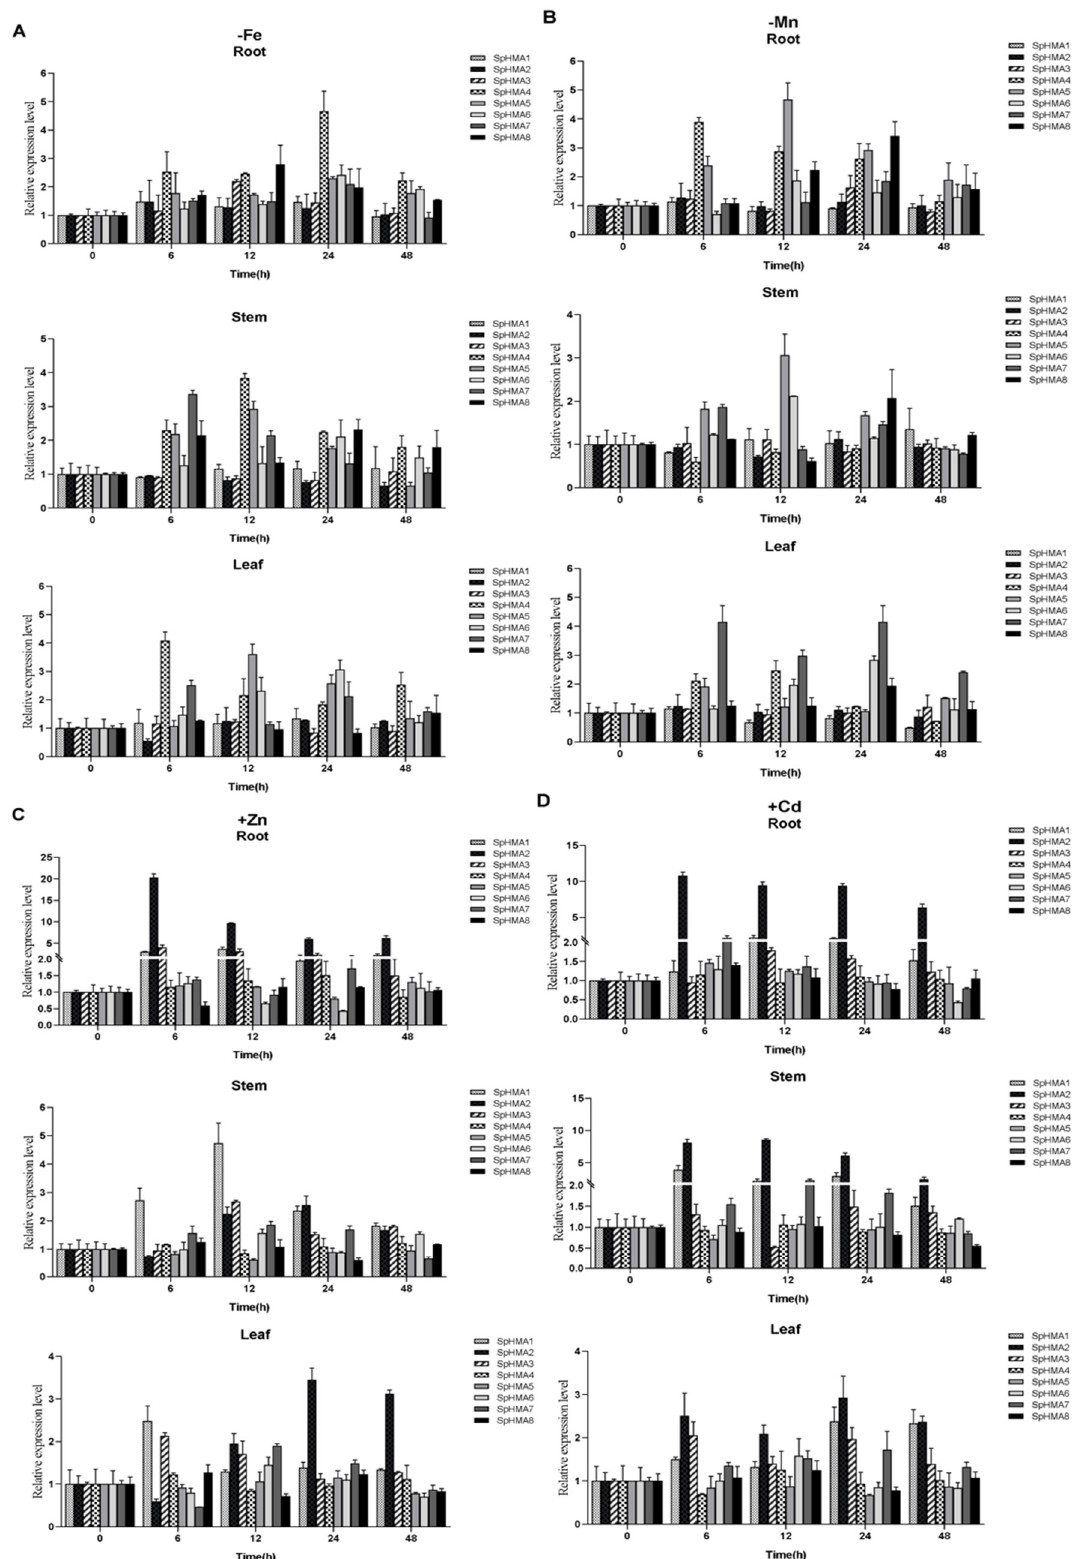
Figure 7. The qRT-PCR expression analysis of 8 SpHMAs under normal and stress condition. The stress treatment conditions were Fe ( A ), Mn ( B ) deficiency and Zn ( C ), Cd ( D ) excess, respectively. The expression levels of untreated (0 h) group were set to 1 as the control. Error bars were derived from three replicates of each experiment.